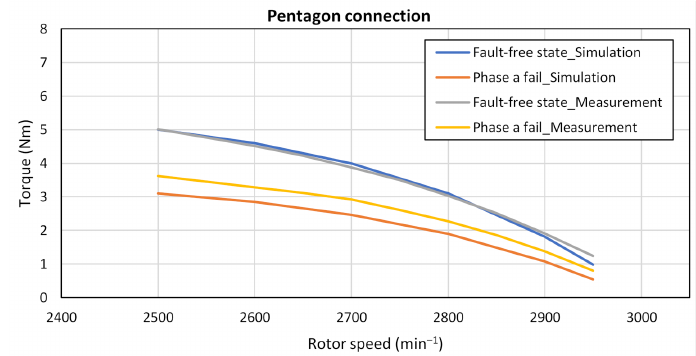
Figure 29. Torque measurement and simulation at 5 fIM for fault-free condition and failure of one phase in a pentagon